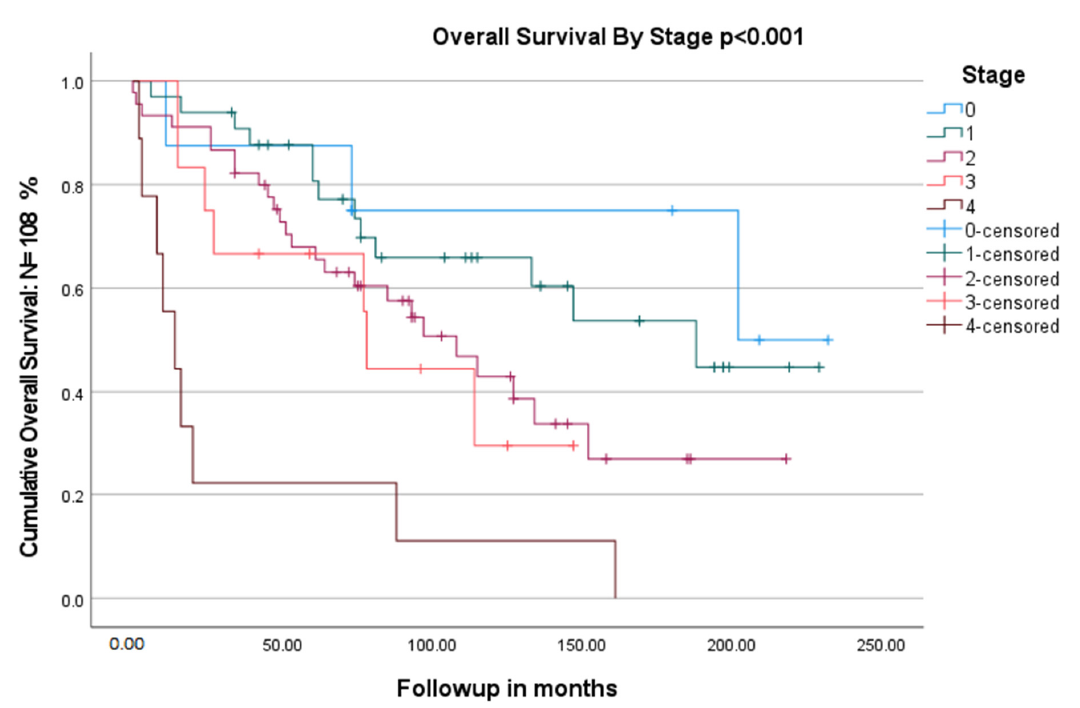
Figure 2. Kaplan – Meier curves for overall survival of 108 men based on stage of breast cancer at the time of diagnosis showed significant differences in overall survival ( p < 0.001).